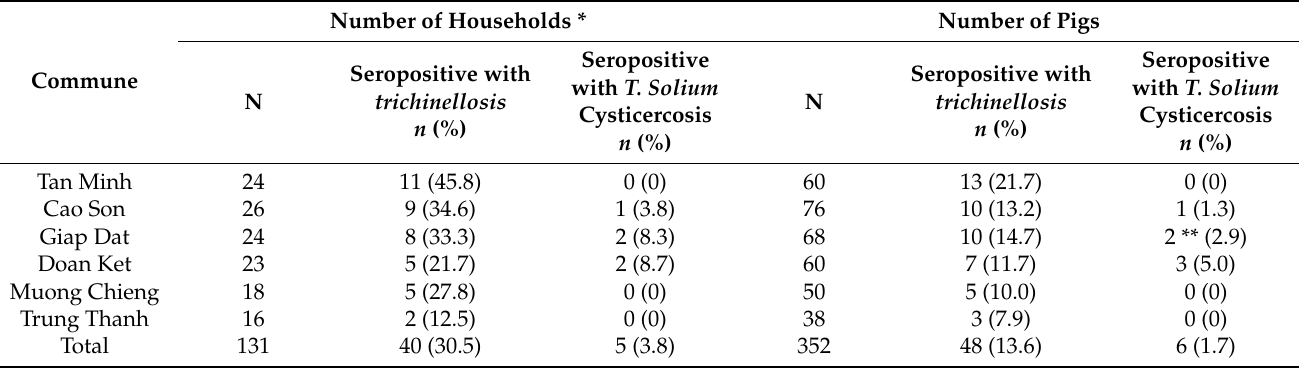
Table 2. Seroprevalence of pig trichinellosis and T. solium cysticercosis by household and individual pig levels in different studied